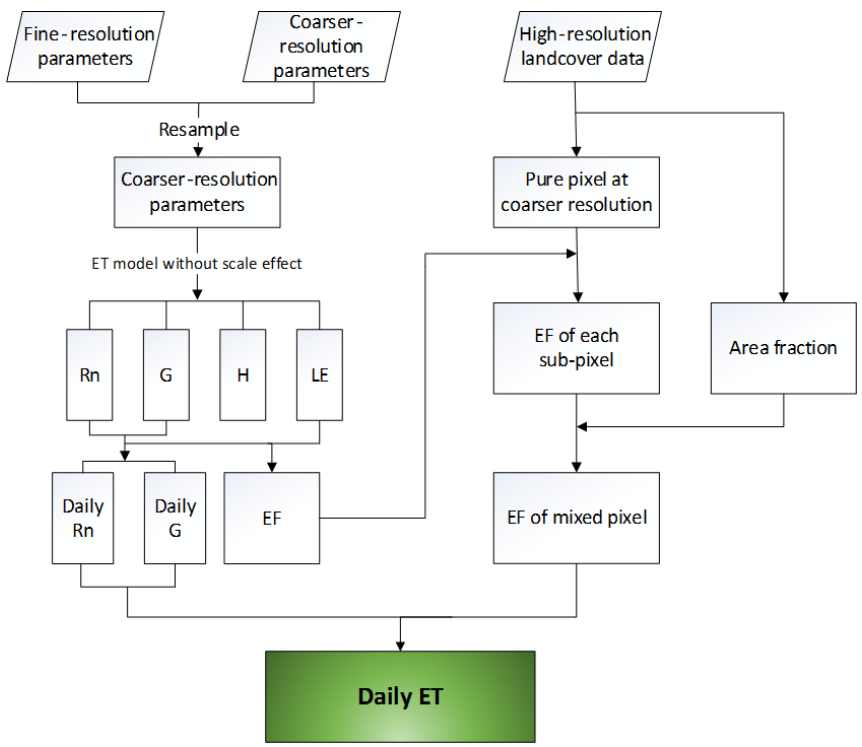
Figure 2. Flowchart of the EFAF, where trapezoids represent the input variables or parameters, and rectangles represent variables or param- eters. The inputs of EFAF encompass the remotely sensed variables or parameters and meteorological forcing dataset. The abbreviations are defined as follows – R n : net radiation; G : soil heat flux; H : sensible heat flux; LE: latent heat flux; EF: evaporative fraction; ET: evapotran- spiration.